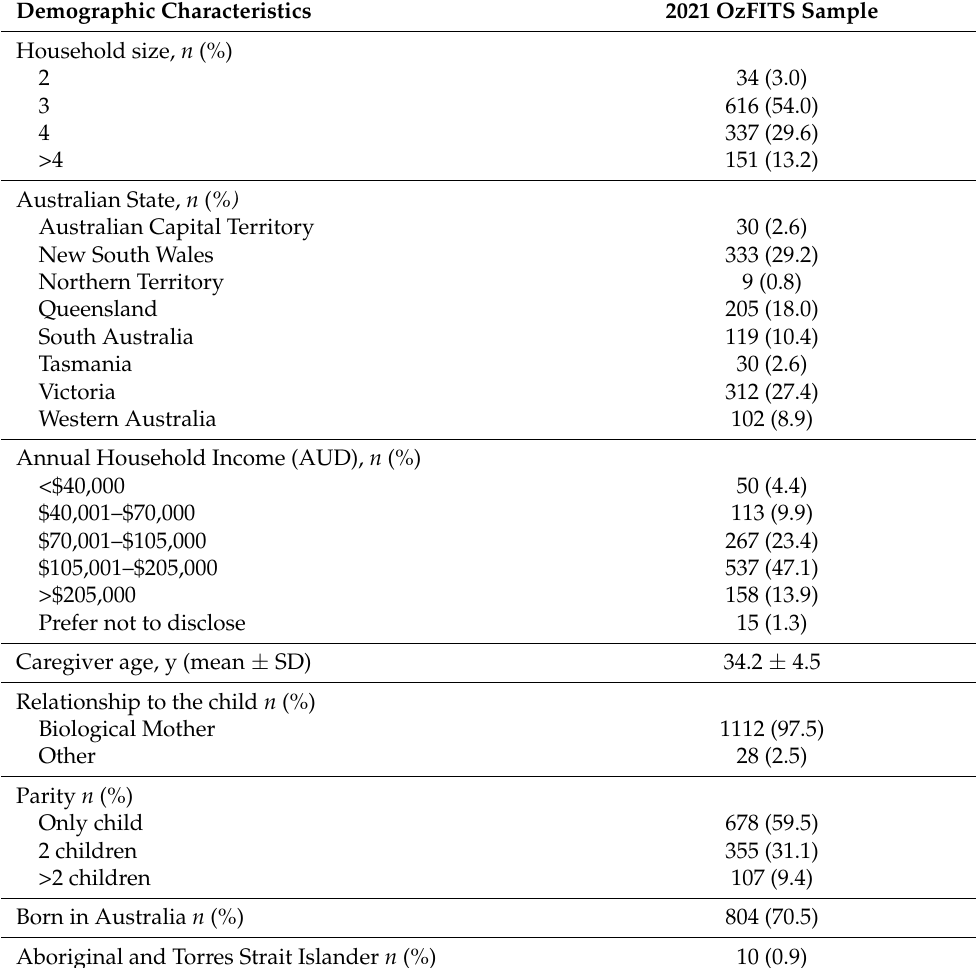
Table 2. Demographic characteristics of 2021 OzFITS sample ( n =